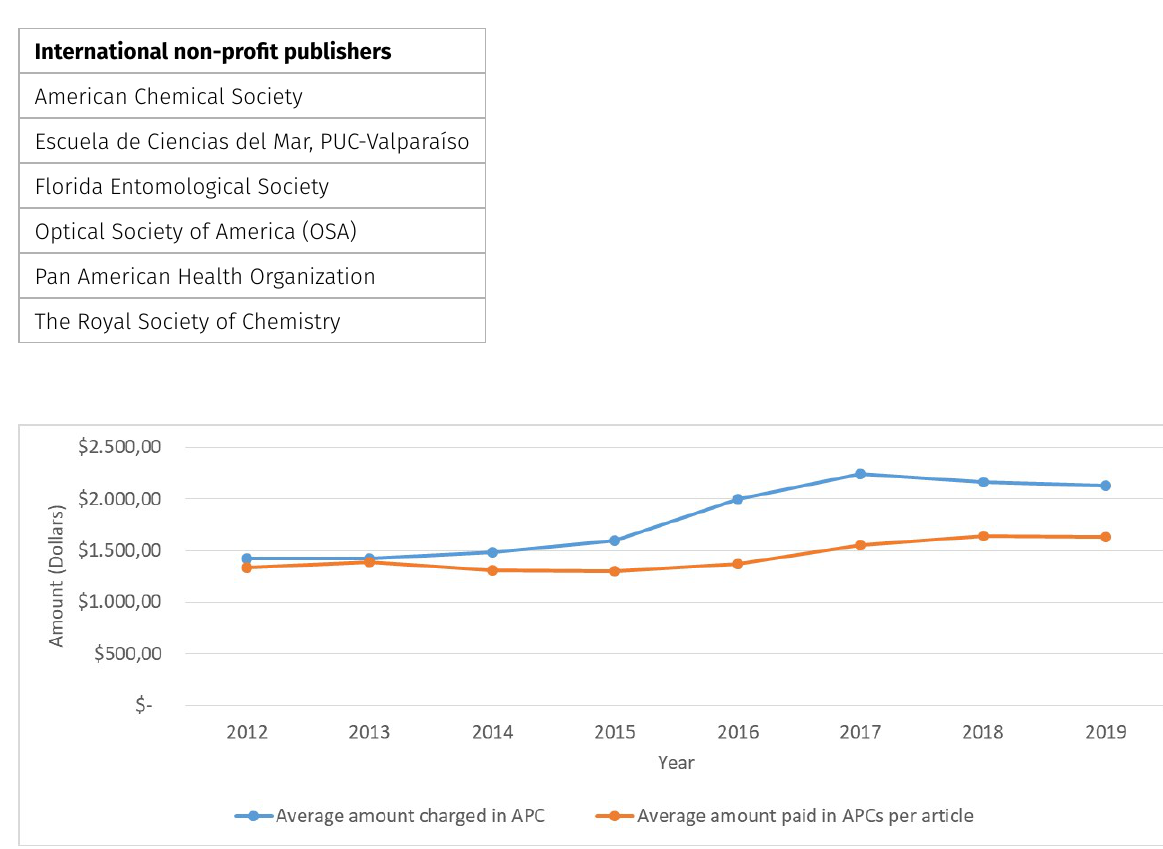
Table V. International non-profit publishers considered in the survey. (Web of Science 2012-2019).